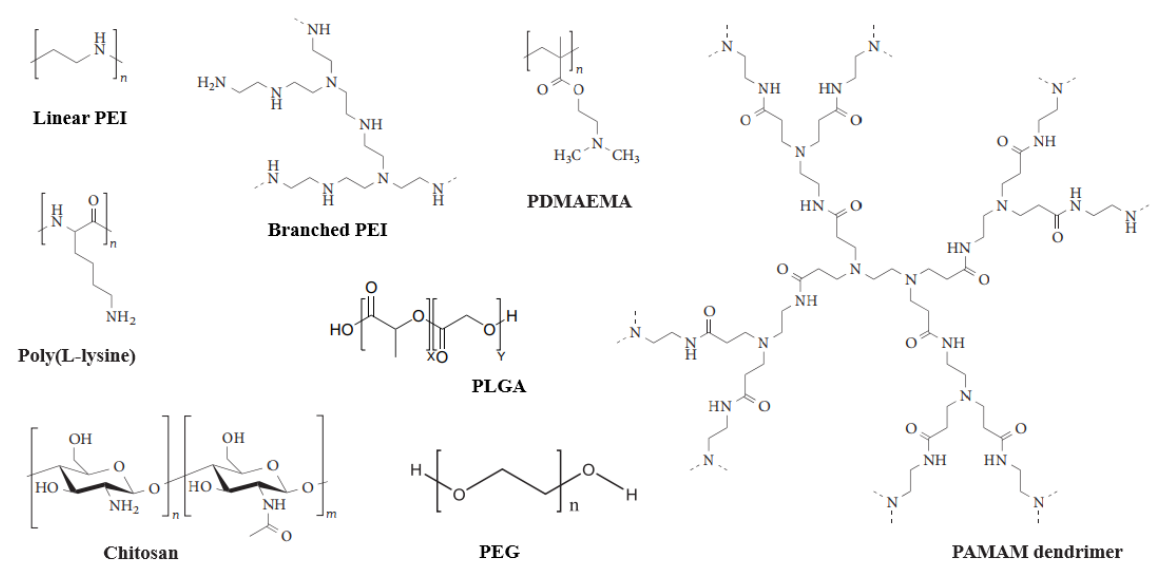
Figure 6. Chemical structures of polymer-based gene vectors [12].